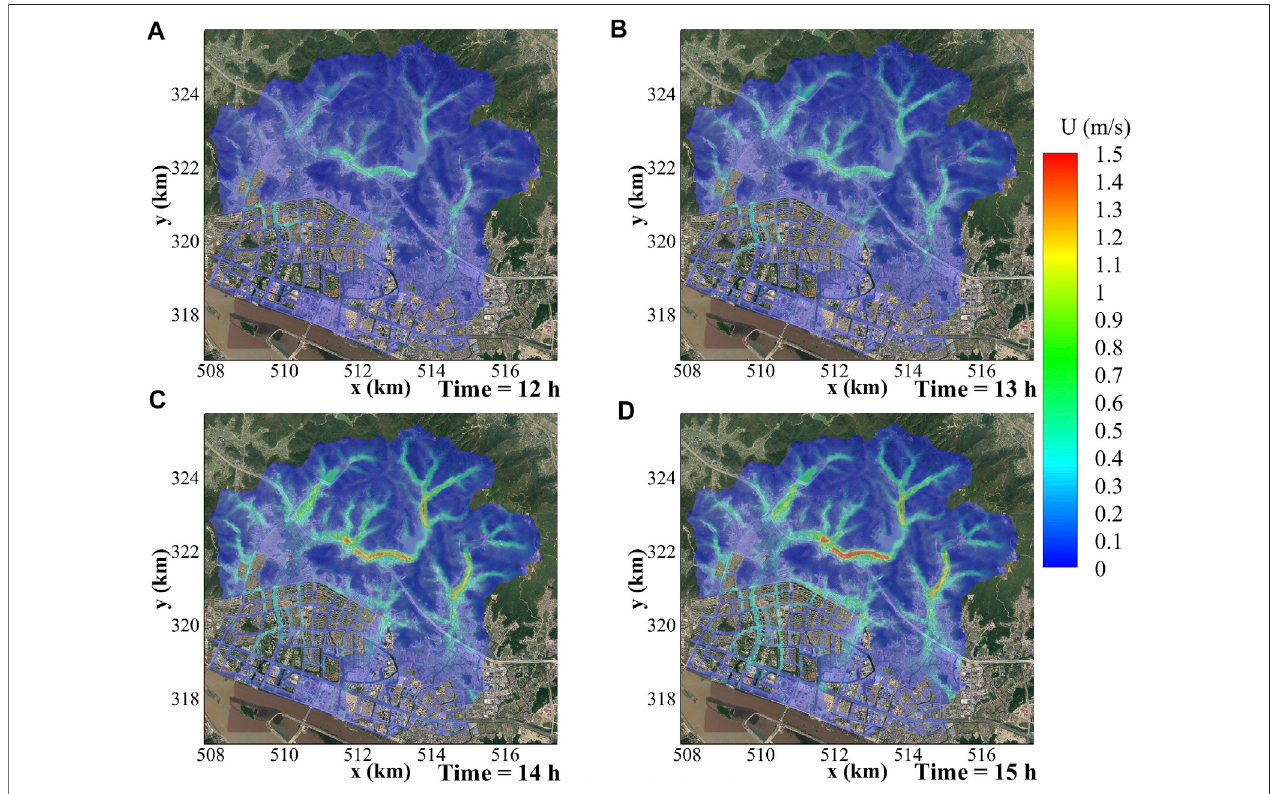
FIGURE 8 | Temporal and spatial evolution of fl ow velocity for PSWM in Case 1 at (A) 12 h, (B) 13 h, (C) 14 h and (D) 15 h.